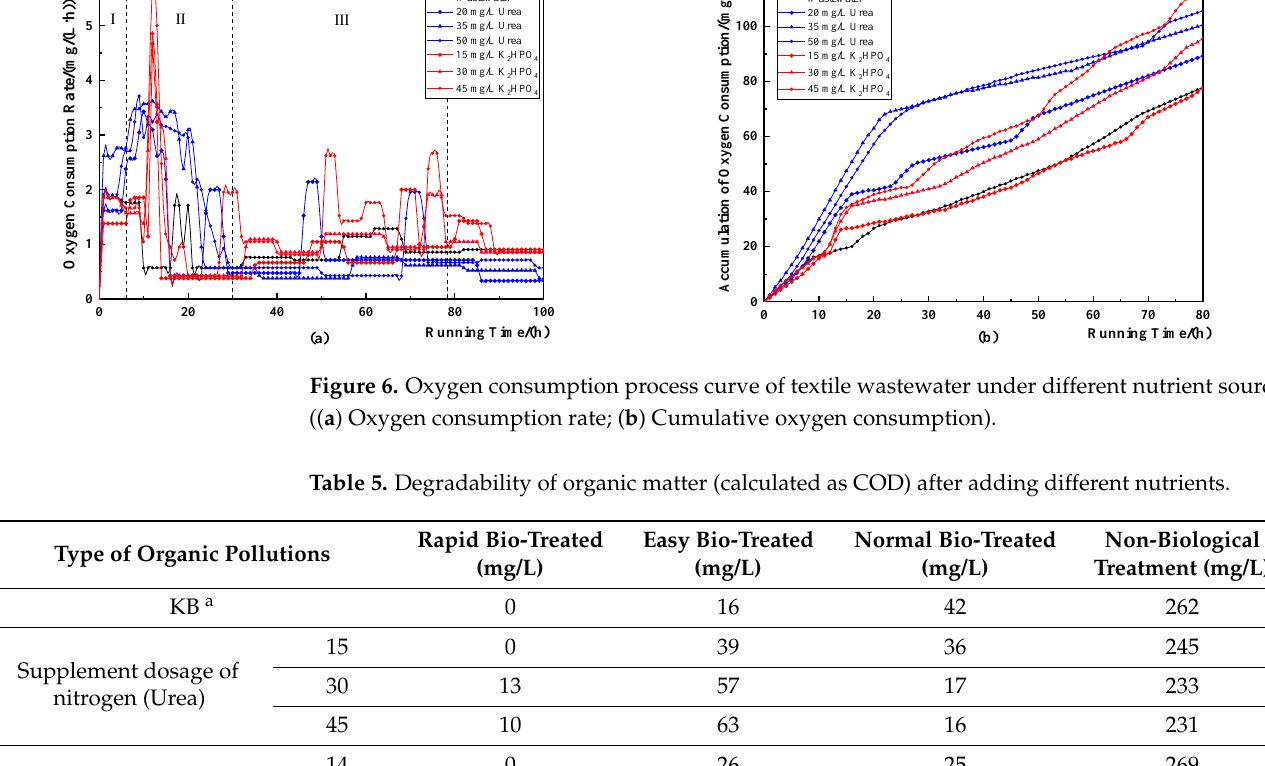
than the 50 mg/L concentration group. The 50 mg/L concentration group had the highest proportion of easy bio-treated organics, which was 70.79%, which are 36.13% and 8.04% higher than the 20 mg/L and 35 mg/L concentration groups, respectively.